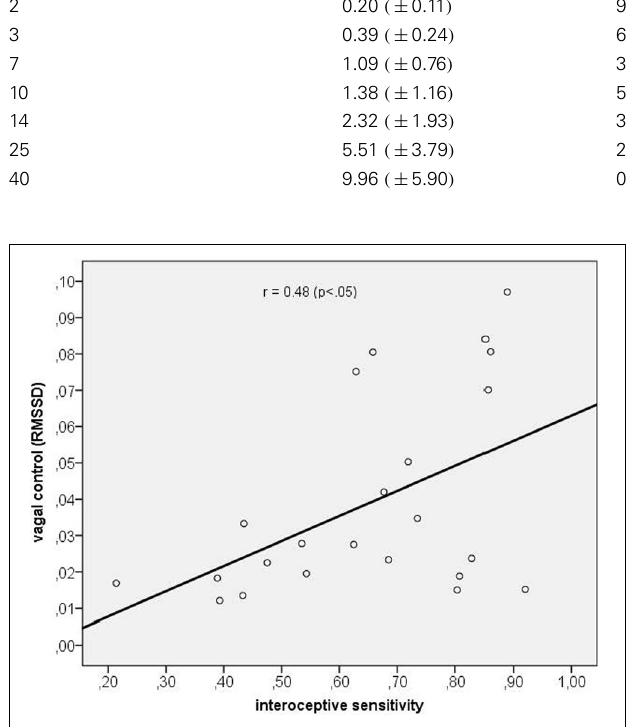
FIGURE 2 | Scatterplot between interoceptive sensitivity and vagal control as indexed by the RMSSD.